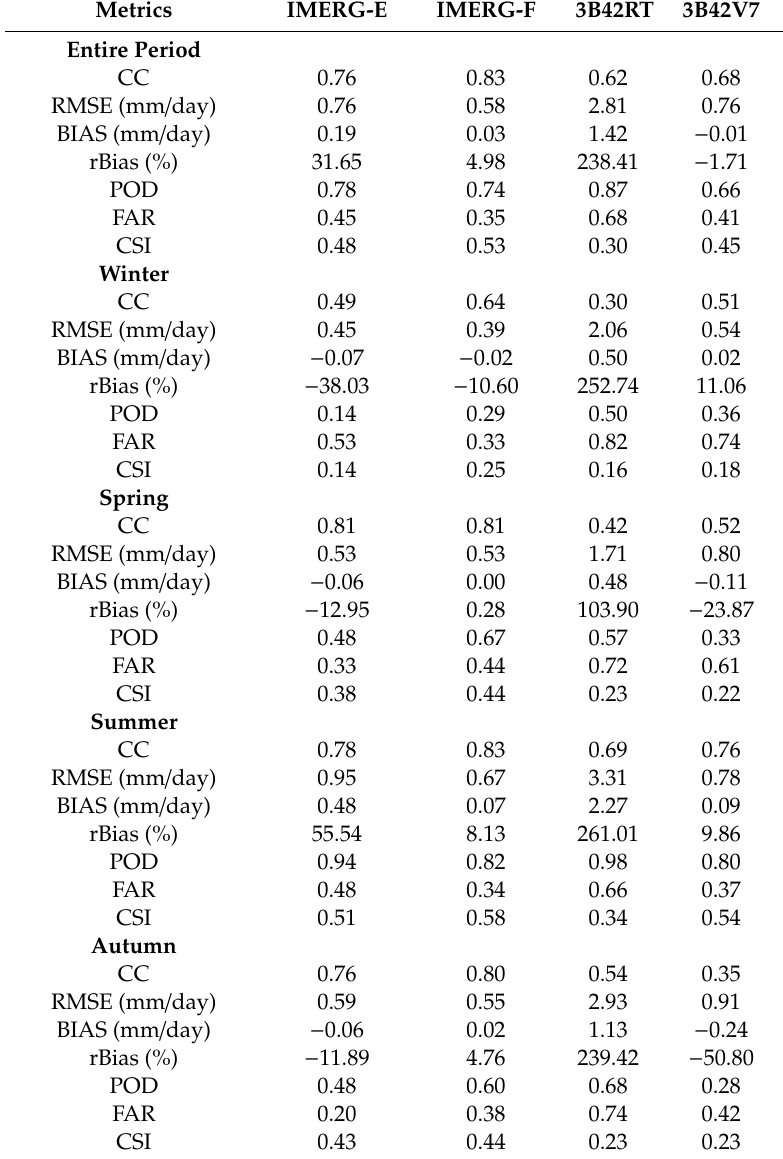
Table 1. Summary of error characteristics of IMERG-E, IMERG-F, 3B42V7, and 3B42RT precipitation products with reference to the gauge observations on the daily and seasonal